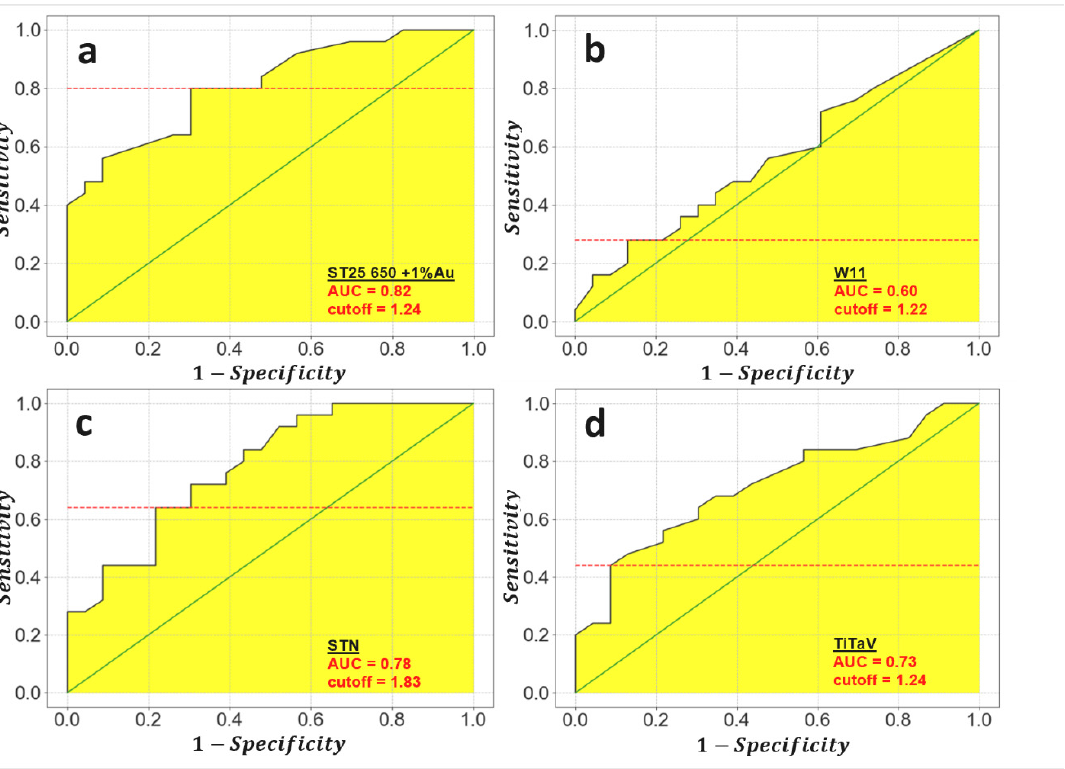
Figure 5. Evaluation of the threshold response amplitude discriminating between tumor affected and healthy affected subjects (TB and HB). Plots of the ROC (receiver operating characteristic) curves of the four sensors (black lines), the equity line (green), and the threshold amplitude computed by the maximum Youden’s index (red dashed lines). The AUC (area under curve) is highlighted in yellow. ( a ), ST25 sensor; ( b ), W11; ( c ), STN; ( d ), TiTaV.